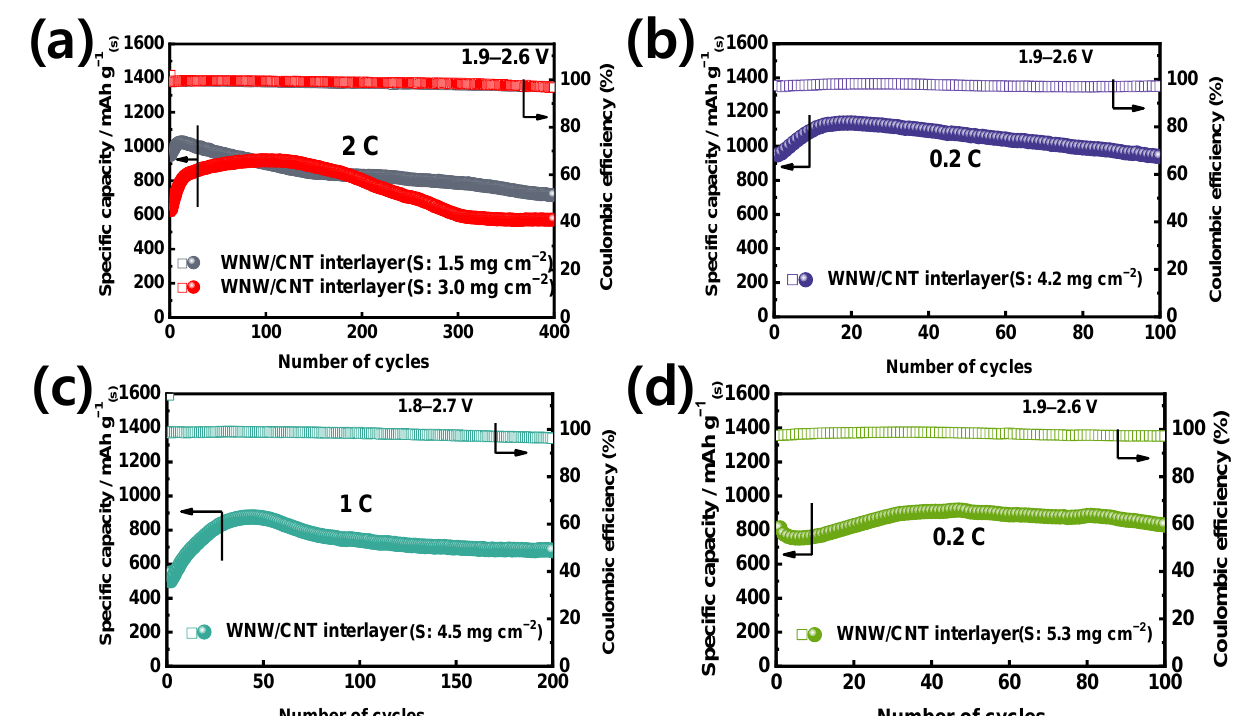
Figure 6. ( a ) Long-term cycling performance of lithium-sulfur cells with a WNW/CNT interlayer at 2 C (sulfur mass loading: 1.5 and 3.0 mg cm − 2 , respectively). Cycling performance of lithium-sulfur cells with sulfur mass loadings of ( b ) 4.2 mg cm − 2 (0.2 C), ( c ) 4.5 mg cm − 2 (1 C), and ( d ) 5.3 mg cm − 2 (0.2 C).